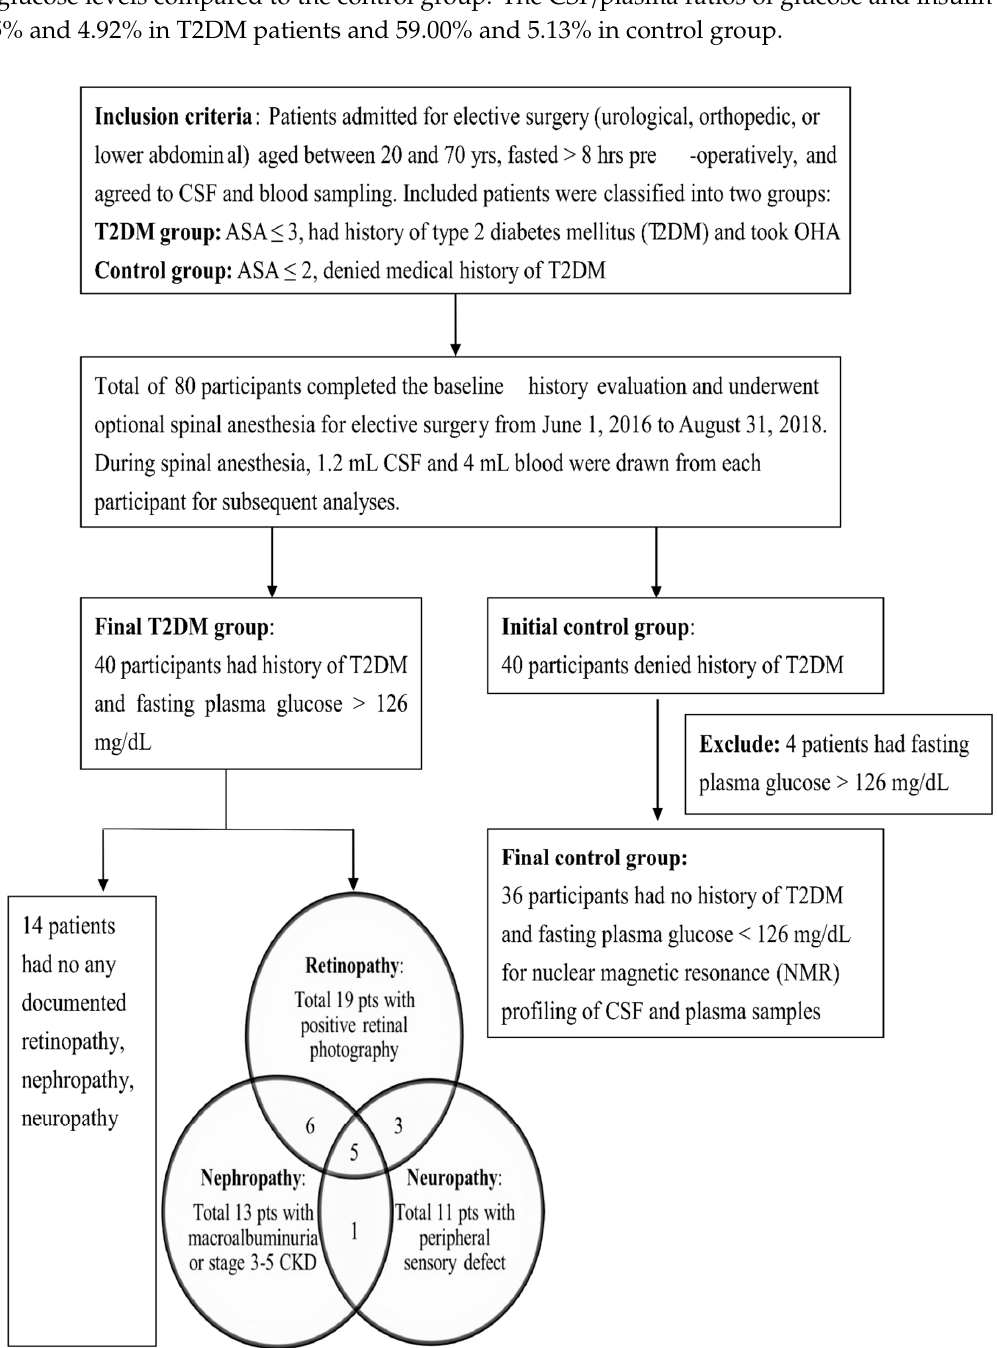
Figure 1. Flow chart for the study design and group separation.